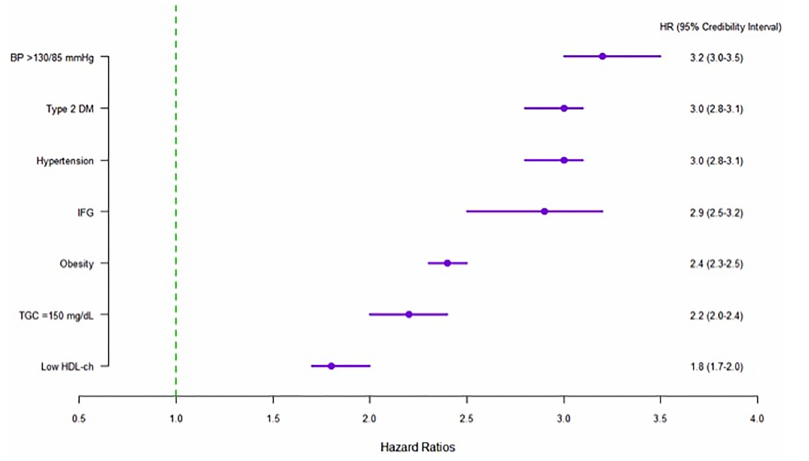
Fig 2. Order in which the components appear and risk first metabolic syndrome episode.